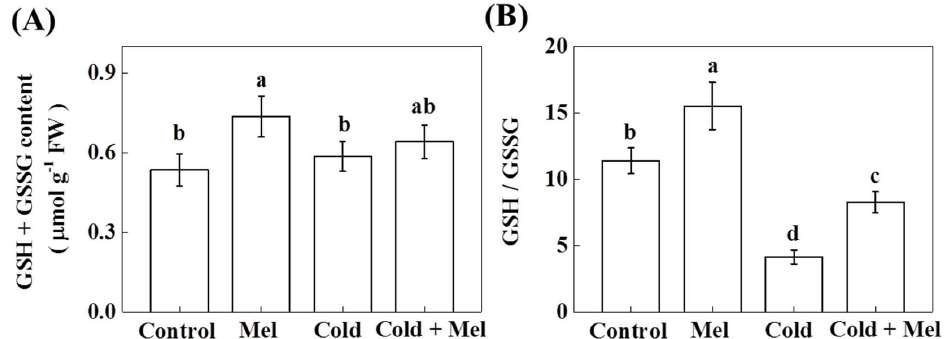
Figure 6. Effect of melatonin application on ( A ) glutathione content and ( B ) redox status in tea leaves under normal and cold stress conditions. Mel, melatonin. GSH, reduced glutathione. GSSG, oxidized glutathione. Each data point presents the mean of six replicates ( ± S.D. (standard deviation)). Means denoted by different letters are significantly different ( p < 0.05) based on the Tukey’s test.